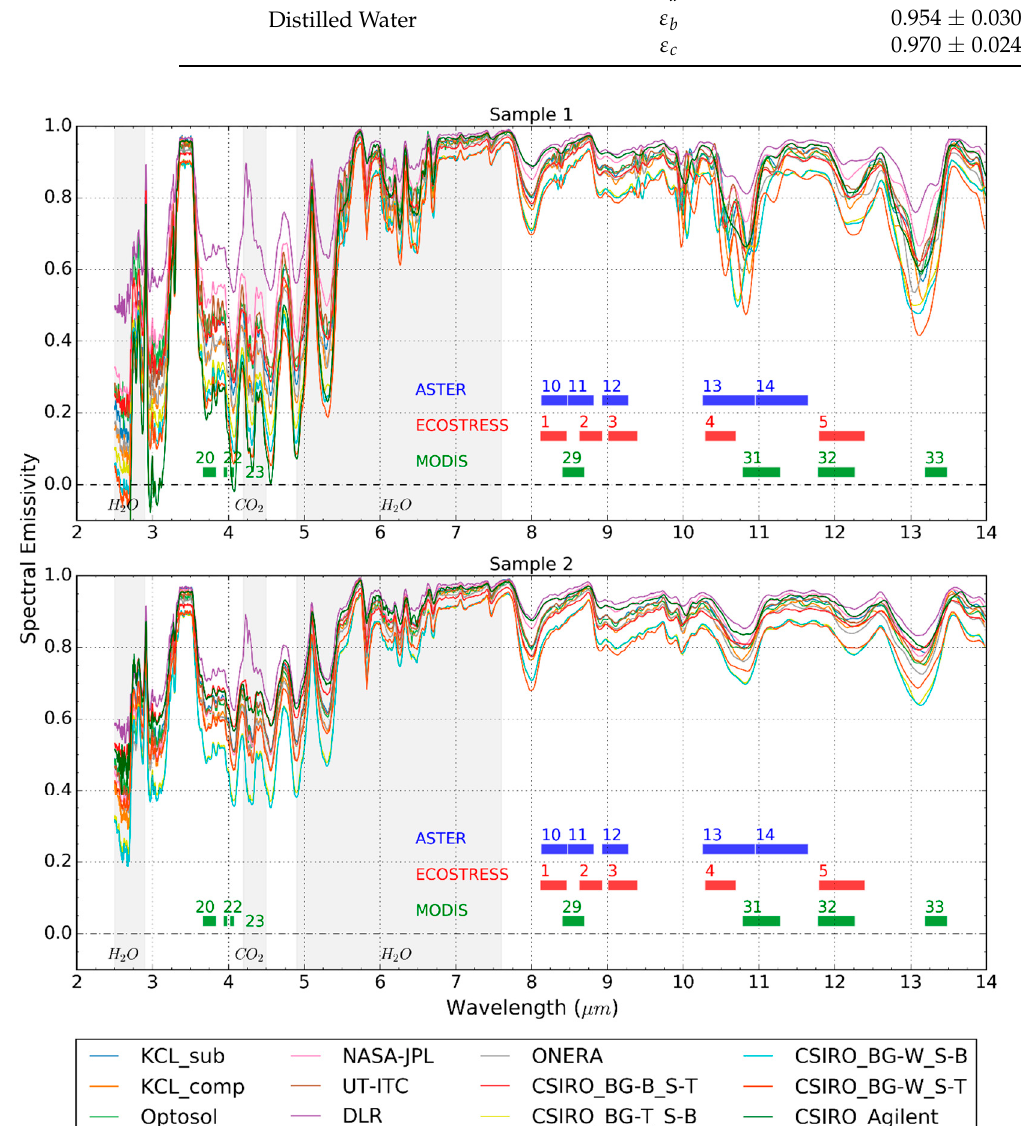
Figure 4. Surface spectral emissivity measurements for artificial Samples 1 and 2, measured at 4 cm − 1 resolution over the 2.5–14 μ m spectral range. The spectral ranges of MODIS bands 20, 22, 23, 29 and 31–33 are indicated, which are used to retrieve LST using the MWIR and LWIR regions in the day/night algorithm detailed in [41]. ECOSTRESS and ASTER thermal band locations are also shown in green, red and blue respectively. The absorption bands of relevant gases (H 2 O and CO 2 ) are indicated through the grey vertical bars. For legend abbreviations see Table